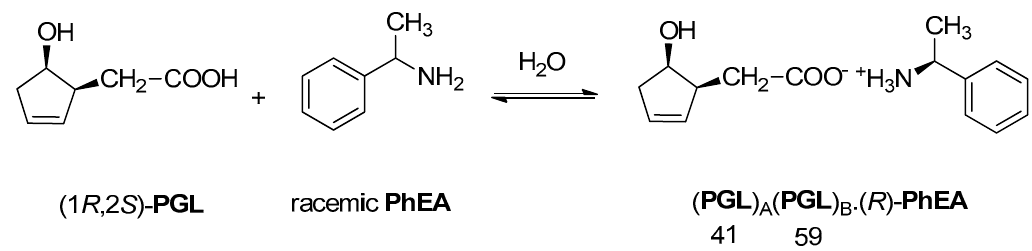
Figure 9. Diastereomeric salt formation with both conformers.